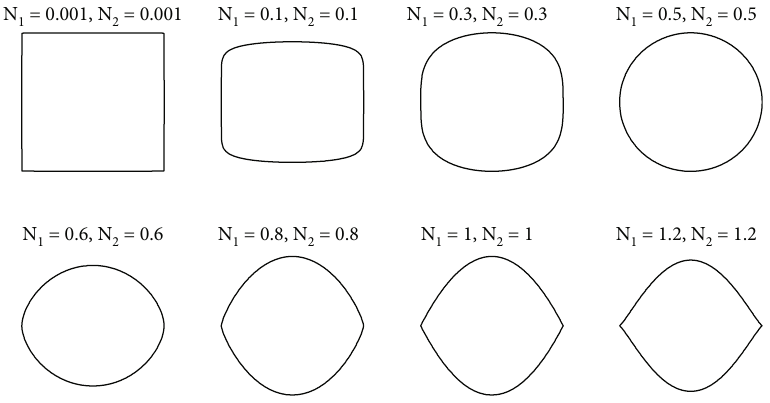
Figure 3: Various missile forebody cross-sectional shapes.